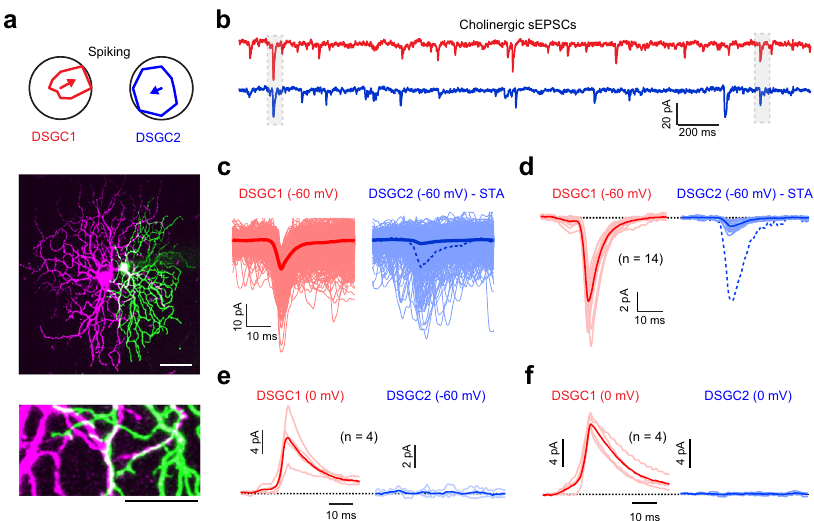
Fig. 2 Rapid, multi-directed cholinergic transmission. a Polar plots depicting the directions encoded by a pair of adjacent DSGCs, based on their spiking responses to spots of light moving in eight different directions (top). The middle panel shows the dendritic morphologies of the same pair of DSGCs imaged using two-photon microscopy (scale bar 50 μ m). The bottom panel shows a magni fi ed view where the dendrites of the two DSGCs co-fasciculate (scale bar 25 μ m). b Simultaneous paired voltage-clamp recordings from the same DSGCs shown in ( a ), illustrating spontaneous cholinergic currents (sEPSCs; which are blocked by a broad spectrum nAChR antagonist 1 μ M DHBE or by the α 6*-speci fi c nAChR blocking peptide PelA-5069; see Supplementary Fig. 2). A few of the sEPSCs are synchronized in the two DSGCs (boxed region). This indicated that ACh release from single vesicles can rapidly activate receptors at two postsynaptic sites, i.e., ACh is multi-directed. c Spontaneous events were detected in a reference DSGC (red) and aligned to their peak (1054 events). Currents over these same time periods in the nearby DSGC are shown in blue. Dark lines indicate the average current over all the sweeps (STA: the sEPSC triggered average). Normalizing the STA to the average sEPSC recorded in the reference cell reveals that its waveform is kinetically indistinguishable from that of the average sEPSC (dashed line). d The average sEPSC (red) and the average STA (blue) across 7 DSGC pairs from 5 retinas. Dark lines indicate the population average and the light lines illustrate responses in individual DSGCs. The dashed blue line shows the average STA normalized to the sEPSC. Note that for each recording two unique values are obtained by considering each DSGC as a reference cell. e , f Correlations are not observed between sIPSCs and sEPSCs ( n = 4 pairs from 2 retinas) ( e ), or between sIPSCs ( n = 4 pairs from 3 retinas) ( f ), recorded simultaneously in a subset of DSGCs shown in ( d ). Dark lines indicate the population average and the light lines illustrate responses in individual DSGCs. Source data are provided as a Source Data fi le for Fig. 2b –